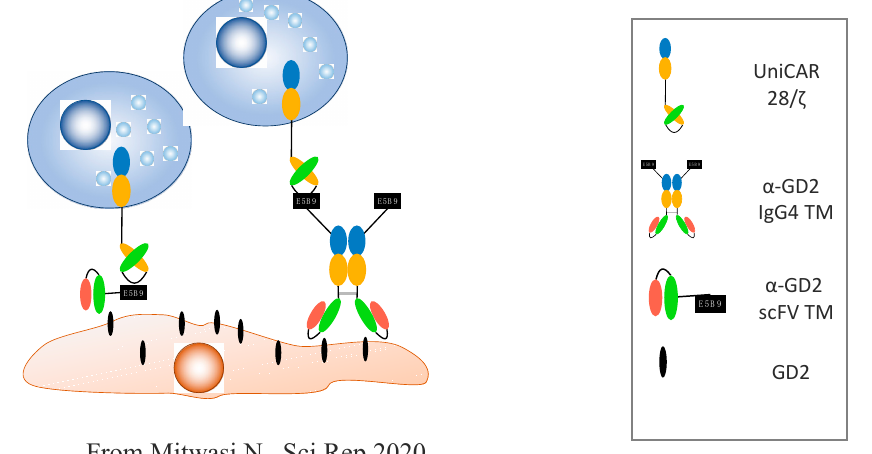
Figure 2. UniCAR-NK-92 action against GD2+ tumoral cells: UniCAR NK-92 is derived from the human tumoral line NK-92. It is composed of (i) an extracellular antibody with a single-chain variable fragment (scFv) directed against the peptidic epitope E5B9, which is not expressed on the host’s cells; (ii) the costimulatory domain CD28; and (iii) the signalization fragment CD3 ζ . NK-92 cells modified to express UniCAR can be redirected against the tumor cells expressing the antigenic target GD2 via specific “Target Modules”. These TMs are composed of a bispecific antibody that recognizes the GD2 antigen on the tumoral cell’s surface on one side, and the E5B9 epitope that interacts with the NK-92 UniCAR on the other. Adapted from Ref. [42].